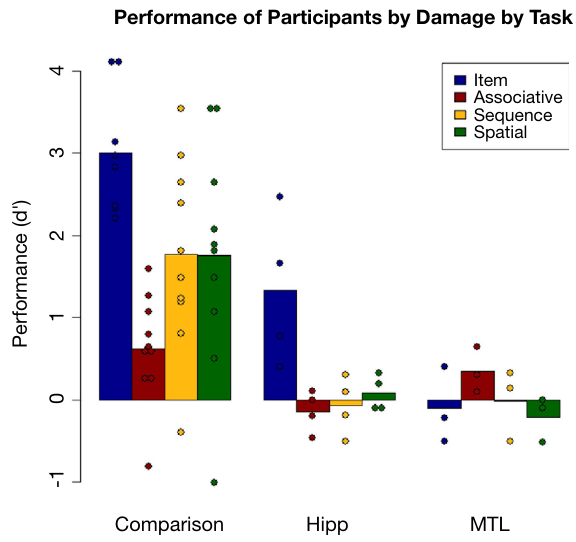
Figure 7 | Performance on each task by group; dots represent individual participants’